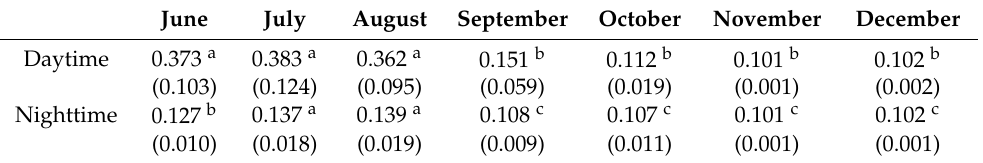
The numbers in parentheses represent the standard error of the data, and the lowercase letters in the upper right corner represent the significant difference of a group of data at the p = 0.05 level, and combined with the Tukey post-test, multiple comparisons were performed on the continuous measurement data. The same letter indicates that the difference is not significant, and different letters indicate that the difference is